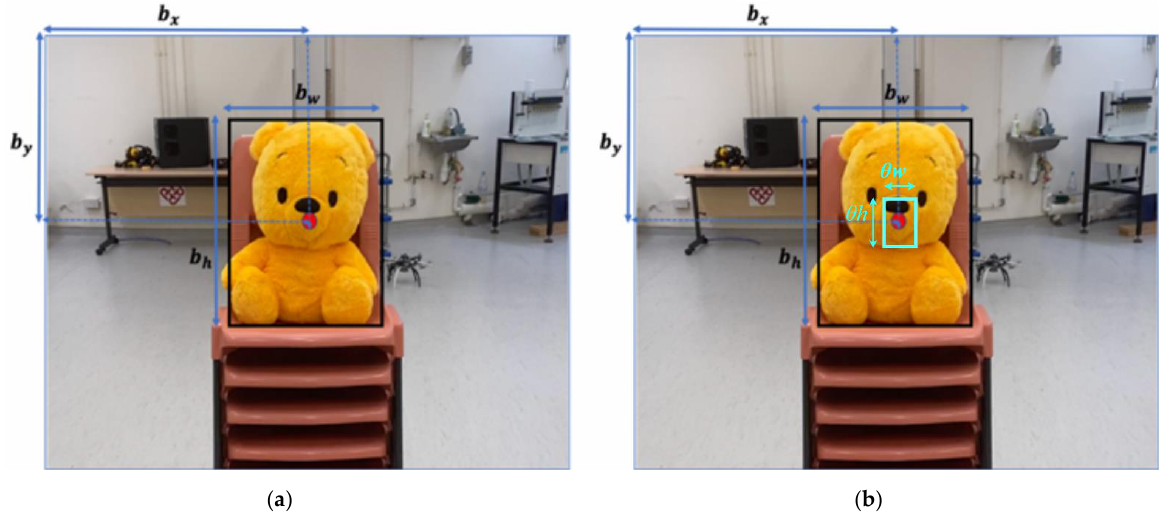
Figure 4. ( a ) Bounding box coordinates on the image plane produced by YOLOv4-Tiny. ( b ) The region of interest for depth information S i